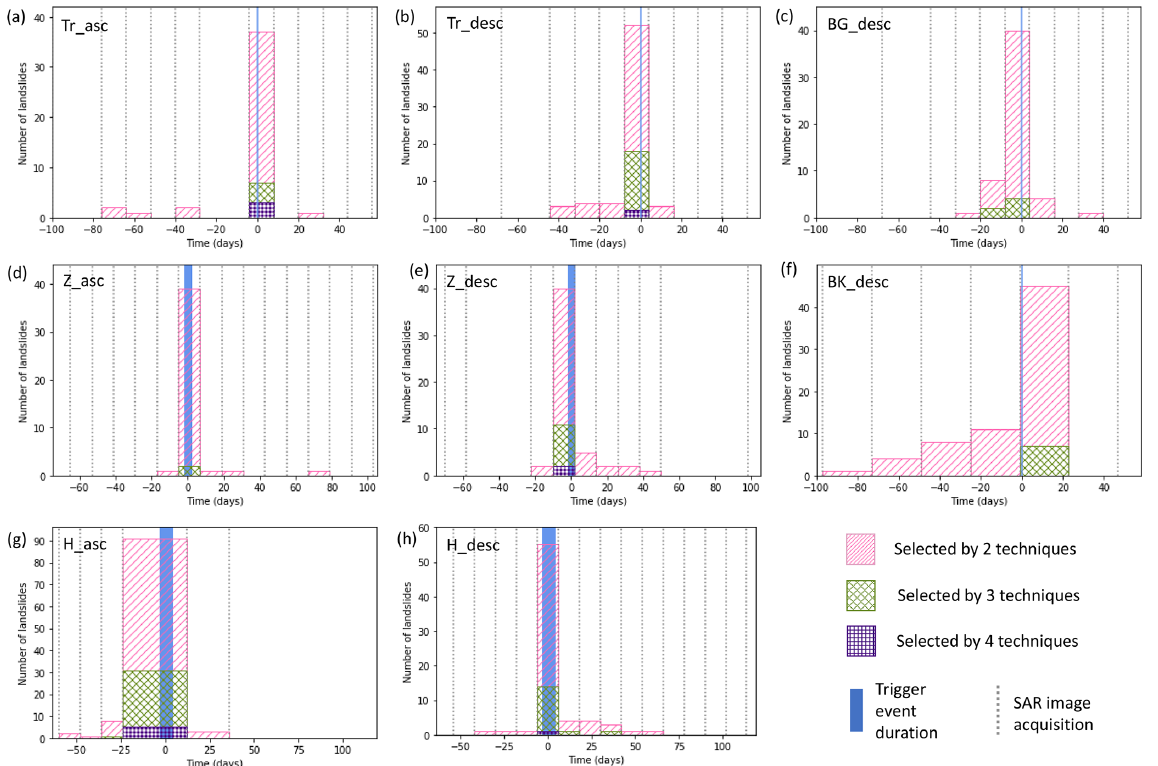
Figure 4. Histograms showing the predicted landslide timings for each event and SAR track when four techniques are used in combination.